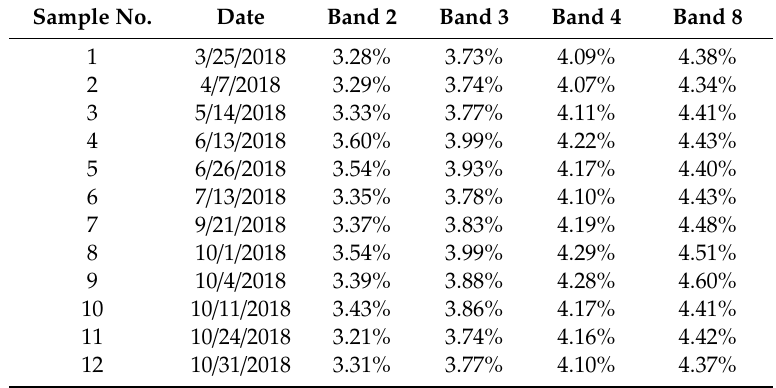
Table 6. Overall uncertainty of the TOA reflectance in bands 2, 3, 4, and 8 of Sentinel-2B / MSI. Sample No.